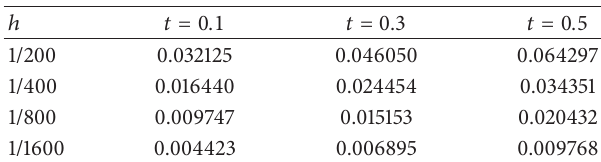
Table 1: The 𝐿 2 errors obtained by VMEFG method with filter at 𝑡 = 0.1 , 0.3, and 0.5.